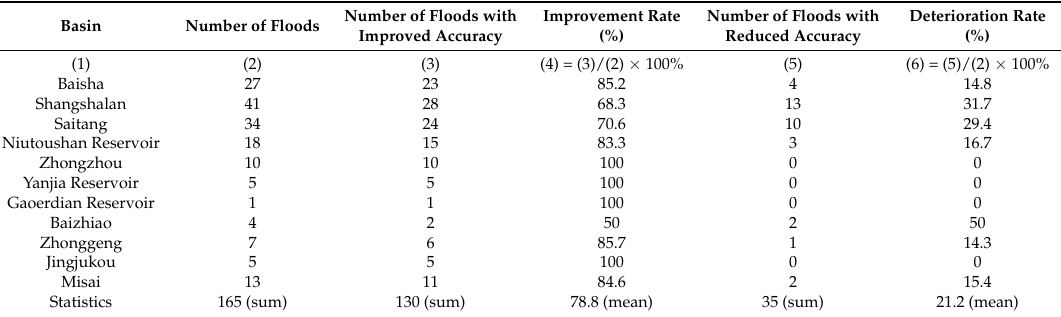
Table 13. Statistics of correction results of under-estimated floods in each basin.